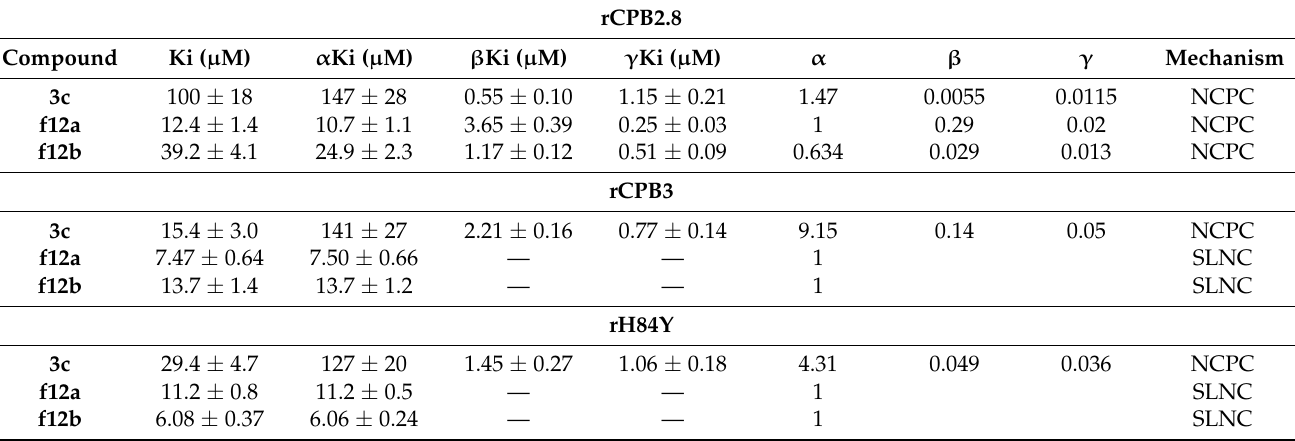
Table 4. Chalcone and flavonoid affinity constants and inhibition mechanisms of enzymes rCPB2.8, rCPB3, and rH84Y.